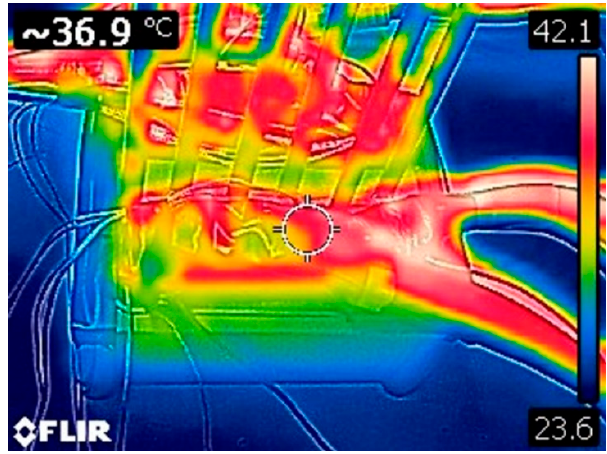
Figure 6. The temperature distribution of the LiC cell at the end of the cycling profile (3000 s).